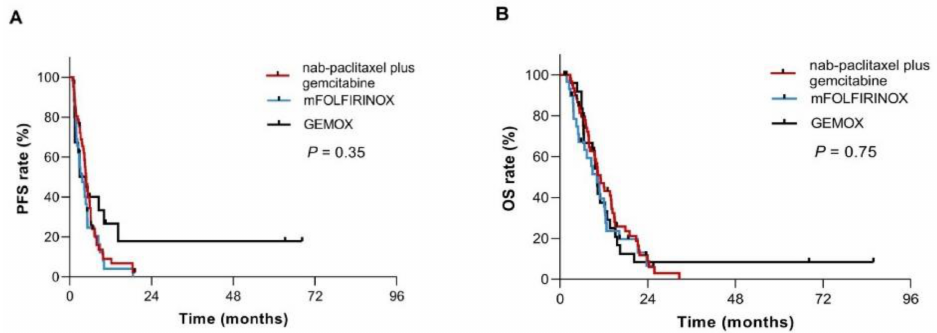
Figure 1. Progression-free survival (PFS) and overall survival (OS) for patients with unresectable pancreatic cancer according to first-line chemotherapy regimens. ( A ) Kaplan-Meier plot of PFS according to the first-line chemotherapy regimens with nab-paclitaxel plus gemcitabine, mFOLFIRINOX and GEMOX;( B )Kaplan-MeierplotsofOSaccordingtofirst-linechemotherapyregimenswithnab-paclitaxel plus gemcitabine, mFOLFIRINOX and GEMOX.